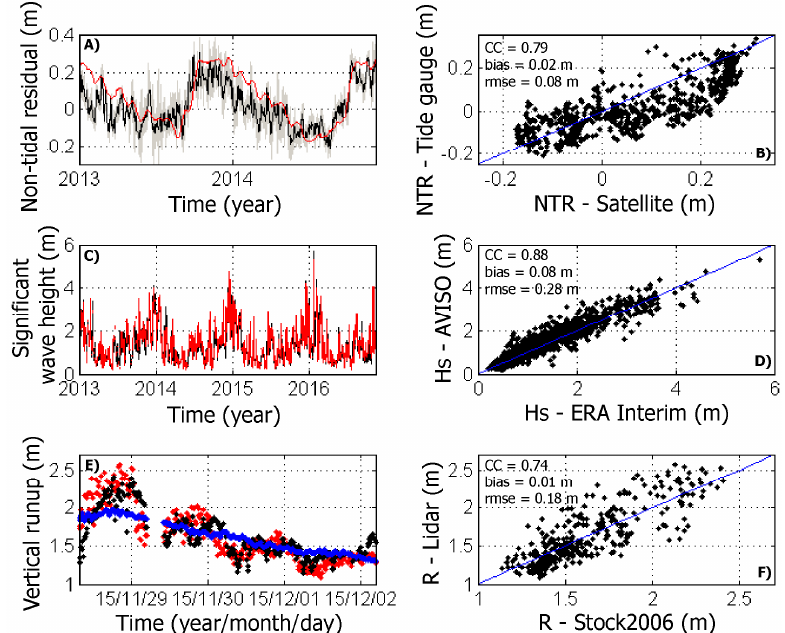
Figure 2. ( A ) time-series of altimetry non-tidal residual (NTR) (black line) and tide gauge NTR (tide gauge 1-day interpolated in red; hourly data in grey ); ( B ) non-tidal residual scatterplot; ( C ) time-series of altimeter H s (red) and ERA-interim H s (black); ( D ) H s scatter diagram; ( E ) time-series of Lidar R observations (red dots) and R estimations (with updated beach slope as black dots; fixed beach slope value as blue dots) using the Equation (2); ( F ) R scatterplot.